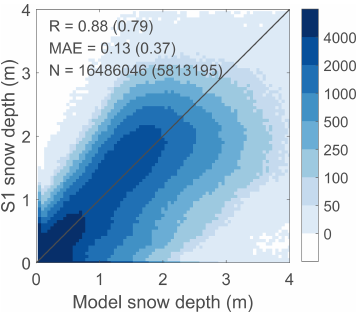
Figure 9. Density plot comparing 1km S1 retrievals of snow depth (m) with corresponding model simulations (m) for August through April 2017–2018 and 2018–2019 (wet snow excluded). The spatio- temporal Pearson correlation R (–), the MAE (m), and number of observations ( N ) are shown at the top left, for scenarios both with and (between brackets) without the inclusion of zero